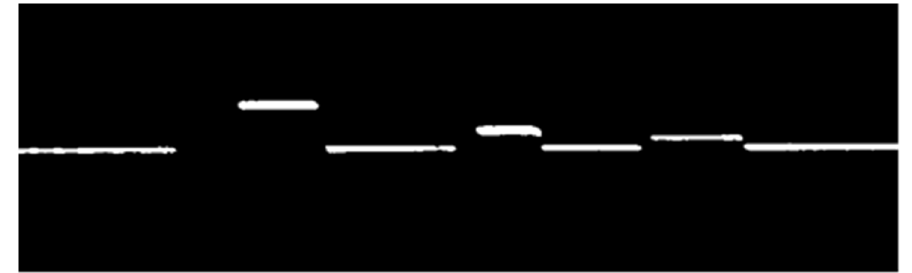
Figure 5. Light stripe area on the surface of the calibration blocks.